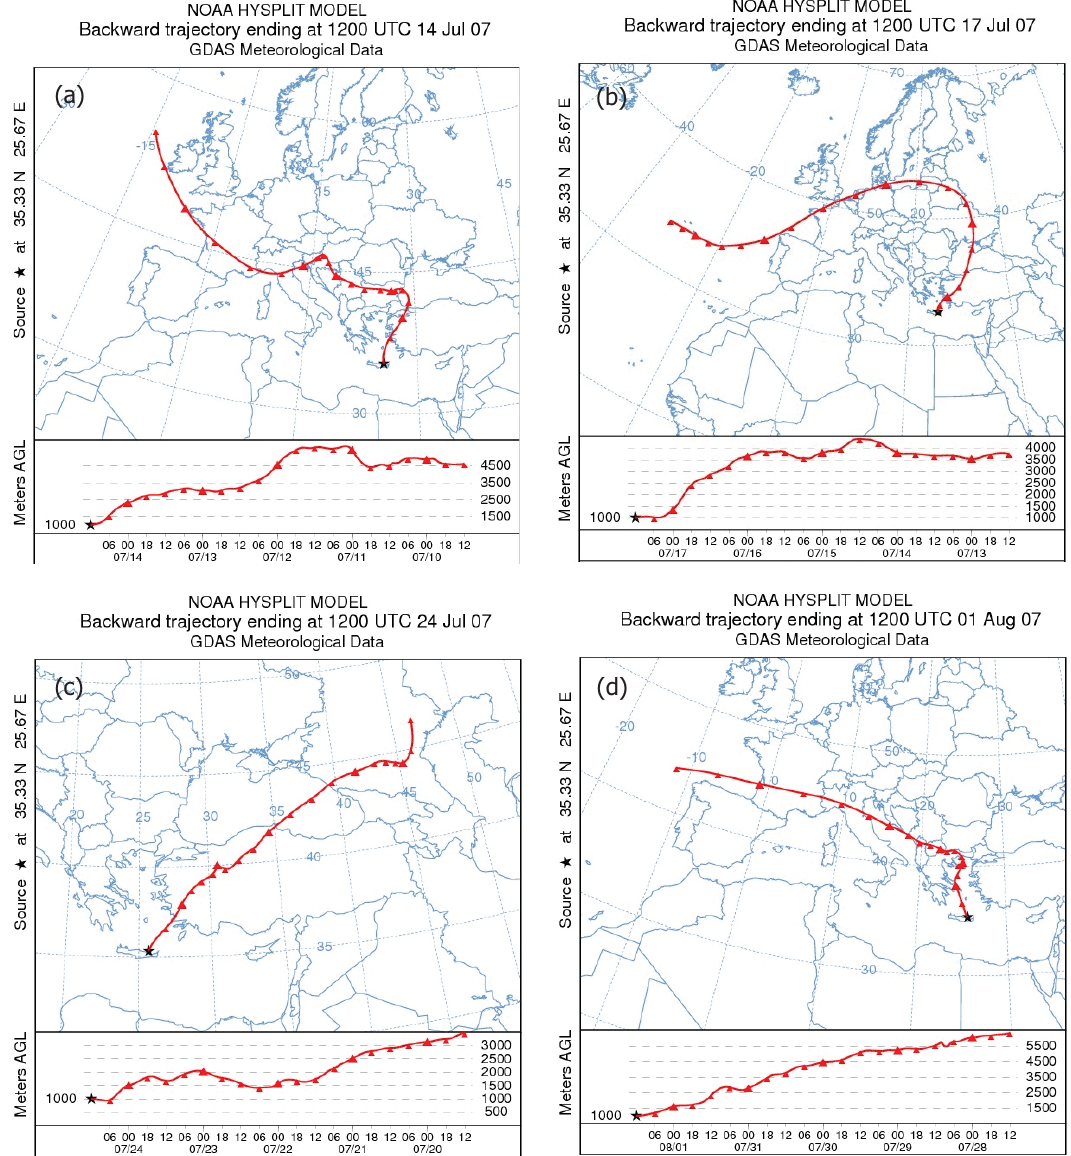
Fig. 1. Maps indicating the location of the sampling site and three-day HYSPLIT back trajectories for characteristic types of air masses sampled during FAME07: (a) 14 July 2007, (b) 17 July 2007, (c) 24 July 2007, and (d) 1 August